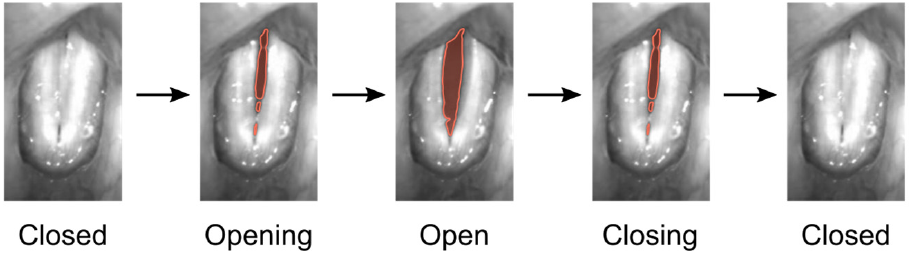
Figure 1. Normal phonatory cycle of the vocal folds recorded by HSV, male subject. The segmented glottis is indicated in red.